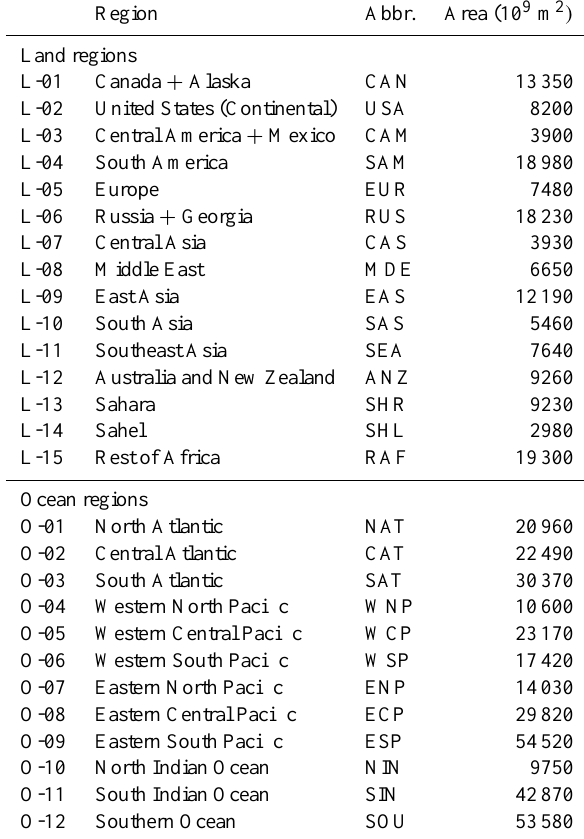
Table 1. Region description, abbreviation, and surface area of 15 land and 12 ocean regions (domains in Fig.